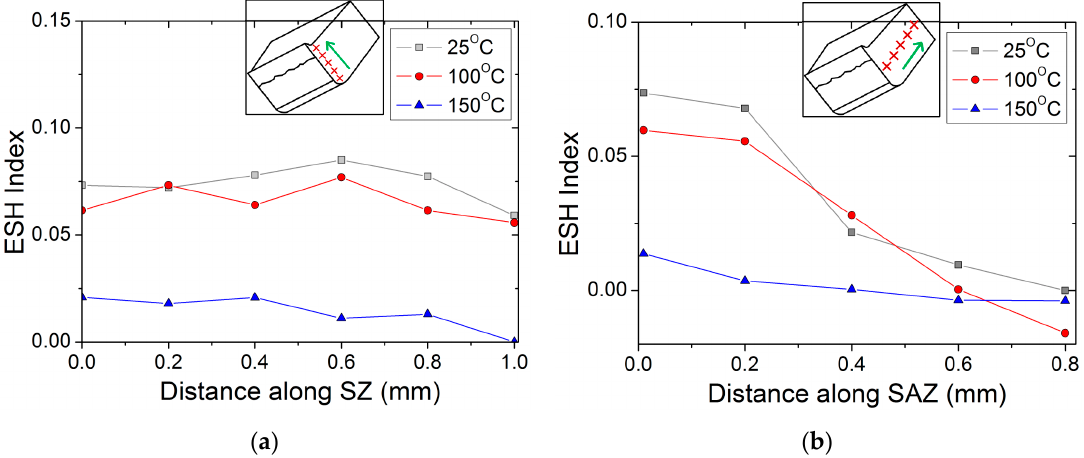
Figure 17. ( a ) Distribution of ESH index along shear zone; ( b ) distribution of ESH index along shear affected zone.